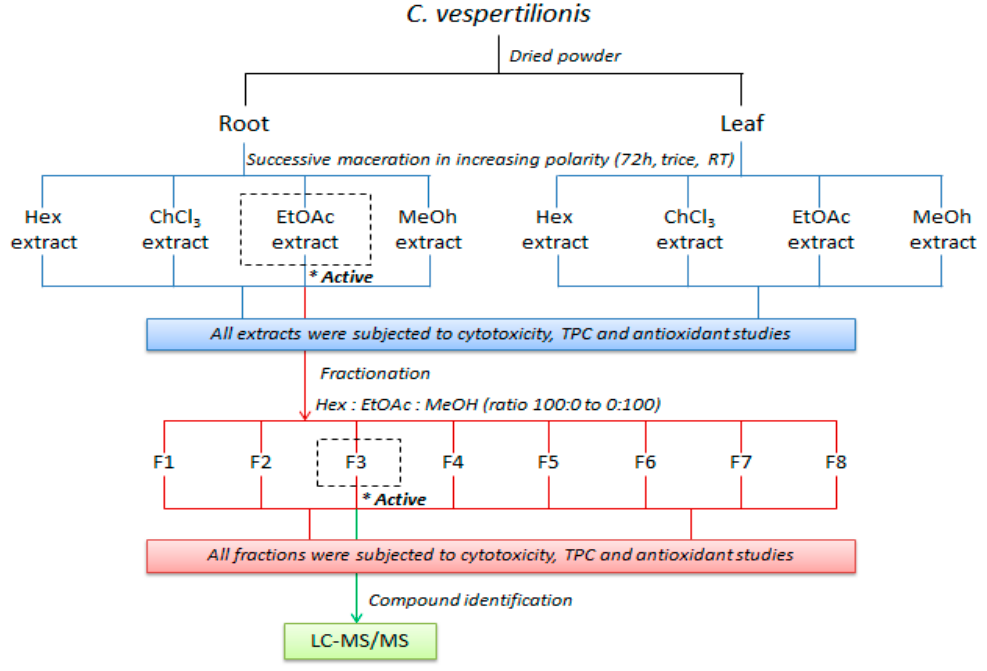
Figure 7. Schematic diagram of the extraction and fractionation of C. vespertilionis .